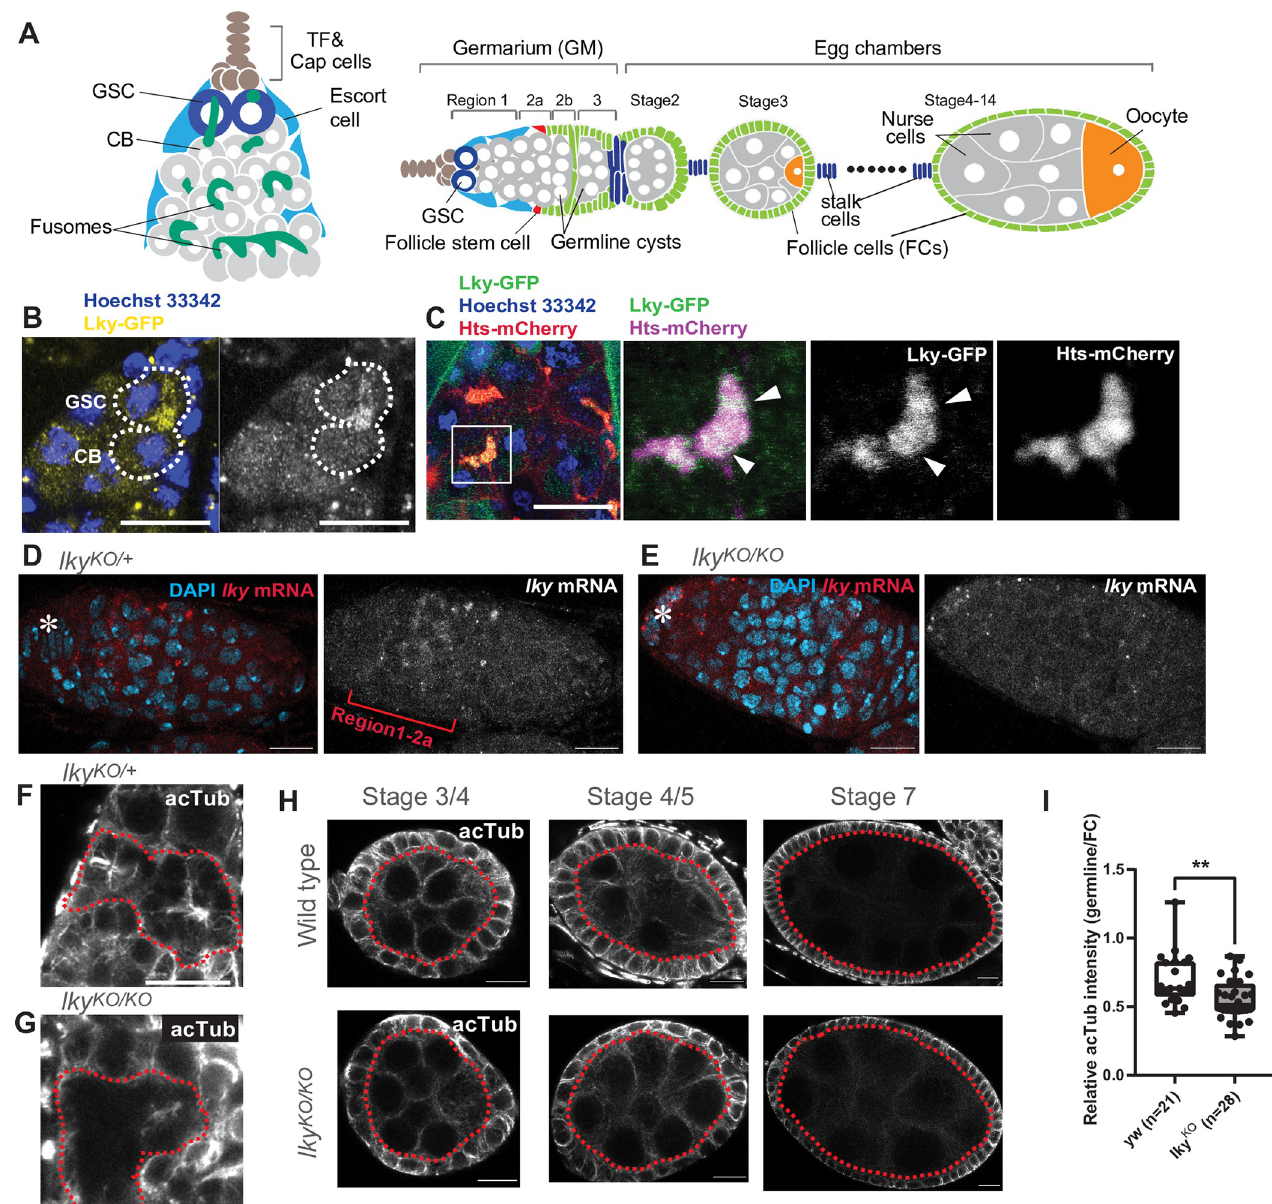
Fig 1. Lky localizes to fusomes and is responsible for α -K40-acetylation in early germline. A ) (Left) A schematic showing Region 1-2a germarium (GM), the anterior-most unit of the ovariole. TF = terminal filament, GSC = germline stem cell, CB = cystoblast. TF and Cap cells forms the stem cell niche. A GSC (magenta) continuously divides to produce the differentiating daughter, the cystoblast (CB). The CB enters 4 incomplete mitotic division to form a 16-cell cyst. Fusomes (green) connect dividing germ cells in the cyst. (Right) A schematic of morphologically distinguishable regions/stages of an ovariole. Follicle stem cells (red) localize between region 2a and 2b in the germarium and proliferate to produce follicle cells or FCs (light green). FCs encapsulate developing germline cysts and a population of FCs is specified as stalk cells (blue). B ) A representative image of a GSC-preCB pair (encircled by a white dotted line) expressing Lky- GFP (yellow) under the germline-specific driver, nosGal4 . Hoechst 33342 (blue) makes nuclei. C ) A representative image of Lky-GFP in a 8-cell cyst. Inset shows fusome with Lky-GFP accumulated around ring canals (or mid-body rings, indicated by white arrowheads). Right three panels in C show magnified images of the inset. Note; because Lky-GFP signal in the fusome reduces after fixation, live tissue was used for imaging for B and C . D, E ) Representative images of FISH against lky mRNA in lky KO /+ germaria ( D ) or lky KO homozygous germaria ( E ). lky transcript was detected in the early stage of germline, Region 1-2a, whereas it was completely absent in lky KO ovary. F, G ) Representative images of immunofluorescent (IF) staining of germaria for anti-acetylated- α Tubulin (acTub) from heterozygous (control) ( F ) or homozygous ( G ) lky KO . Region 2a cysts are encircled by red broken lines. H ) Representative images of germline cysts of egg chambers at the indicated stage stained with acTub. I ) A graph shows relative intensities of acTub staining in wild type (yw) and lky KO germline cysts up to stage 5. Cytoplasmic germline measurements were divided by the cytoplasmic acTub fluorescence intensity of adjacent follicle cells used for internal control. Box plot shows 25–75% (box), median (band inside) and minimum to maximum (whiskers) with each data point representing a single